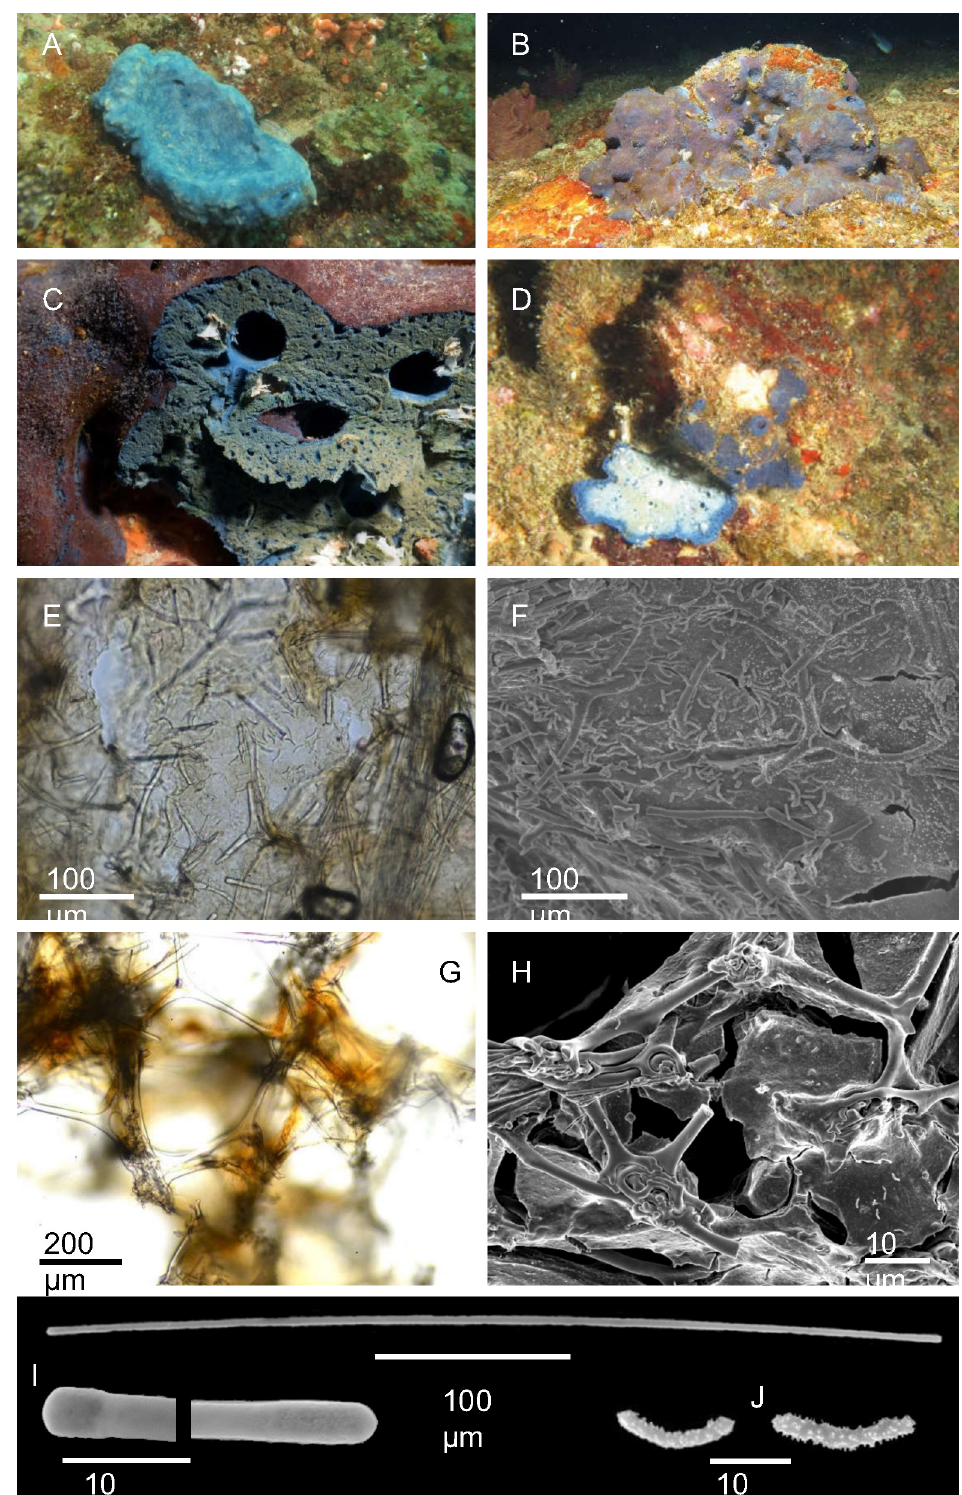
Fig. 14. Theonella timmi Samaai et al. 2019. A–D . The specimens PdO17, PO18, PO36 and PO19, respectively, in situ . E . Ectosome with phyllotriaenes and rhabds. F . Ectosomal skeleton with phyllotriaenes and rhabds (SEM). G . Tetraclone desmas of the choanosome. H . Tetraclone desmas of the choanosome (SEM). I . Strongyle and magnification of the tips. J . Bent